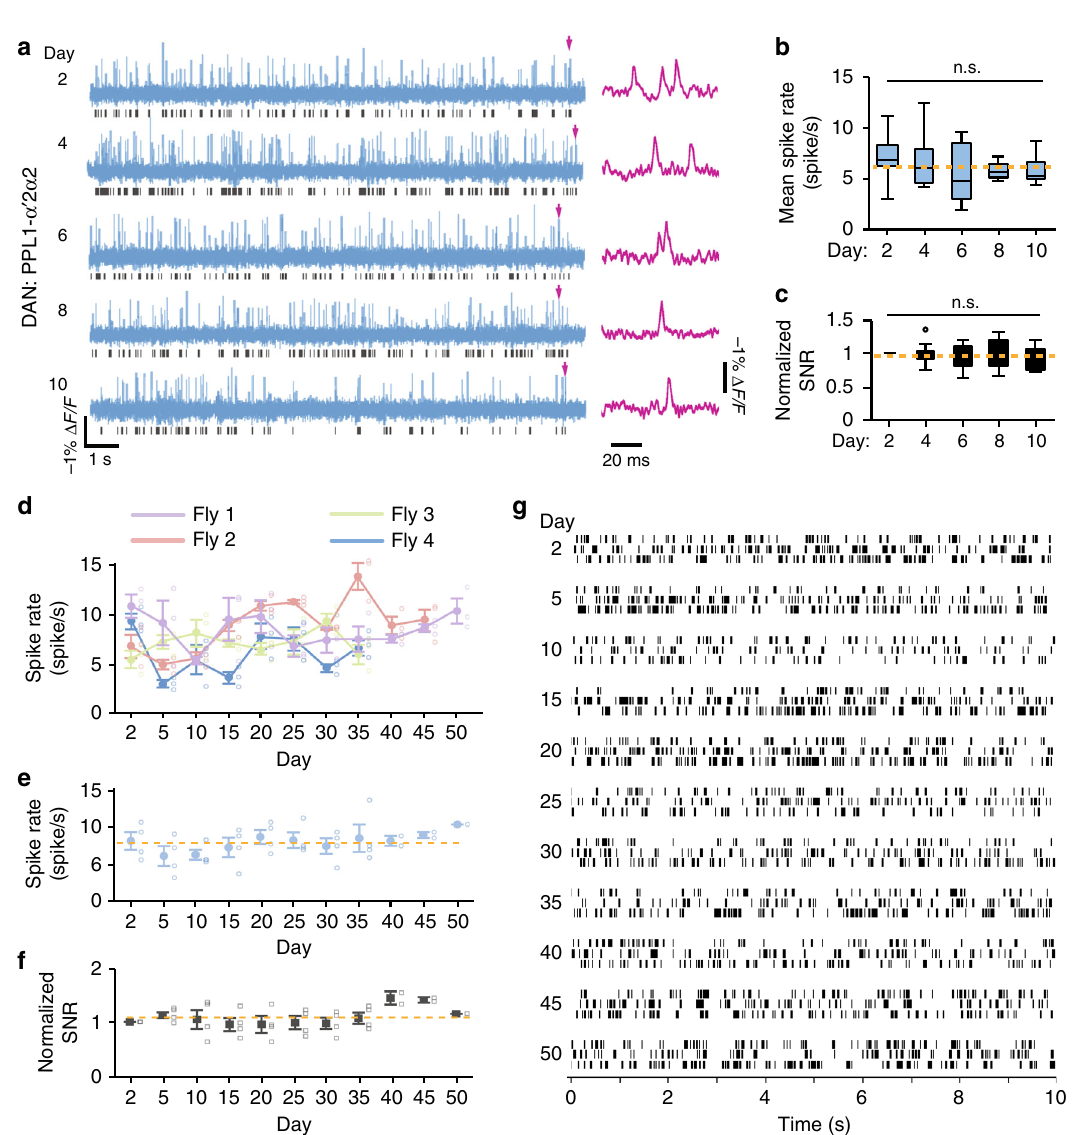
Fig. 6 Imaging neural voltage dynamics for 30 – 50 days in live fl ies. a Traces (blue) of spontaneous activity of a PPL1- α ’ 2 α 2 dopamine neuron expressing the Ace2N-2AA-mNeon voltage indicator in a MB058B-GAL4 > 20 × UAS-Ace2N-2AA-mNeon fl y, alongside magni fi ed views (magenta) of individual spikes marked with arrows. Raster plots below each voltage trace show the corresponding spike trains. b , c Box-and-whisker plots showing that spontaneous spiking rates ( b ) and normalized signal-noise-ratios (SNRs) of optical spike detection ( c ) in PPL1- α ’ 2 α 2 neurons were stable for 10 days ( P = 0.7 and P = 0.2, respectively; n = 10 female fl ies; Friedman ANOVA). We de fi ned SNR as the mean signal amplitude per spike divided by the s.d. of the baseline voltage signal. We normalized SNR values in each fl y to the values measured on Day 2. For each fl y, during each session we acquired three separate 10-s- recordings of spontaneous spiking. We averaged spiking rates and SNR values for each fl y across these three recordings; using the resulting mean values we computed the box-and-whisker elements for each session. d Rates of spontaneous spiking by PPL1- α ’ 2 α 2 neurons in four female MB058B- GAL4 > 20 × UAS-Ace2N-2AA-mNeon fl ies. Open data points: values from individual 10-s-long recordings. Closed data points: mean values averaged across the three recordings per session performed for each fl y. Only one fl y survived 50 days. e , f Mean fi ring rates ( e ) and normalized signal-noise-ratios (SNR) ( f ) of spiking in PPL1- α ’ 2 α 2 neurons for the same fl ies as in d . SNR values normalized in each fl y to the values from Day 2. Closed data points: mean values averaged across the four fl ies. Open data points: values from individual fl ies. g Raster plots of spiking activity of a single PPL1- α ’ 2 α 2 neuron in the fl y that survived 50 days. Error bars in d – f : s.e.m. Yellow dashed lines: time-averaged mean values. In box-and-whisker plots, boxes cover the middle two quartiles, horizontal lines inside boxes denote median values, whiskers extend to 1.5 times the interquartile range, and outlier data points are shown